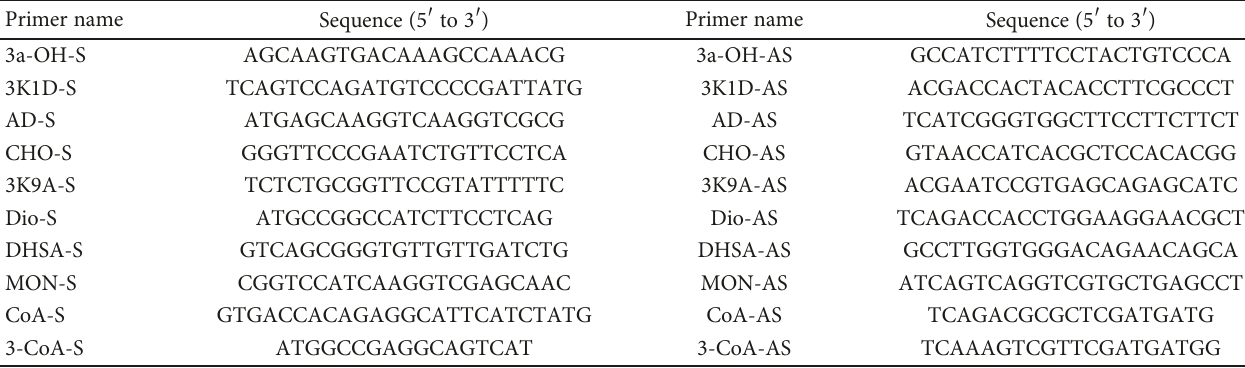
Table 1: PCR ampli fi cation primers.